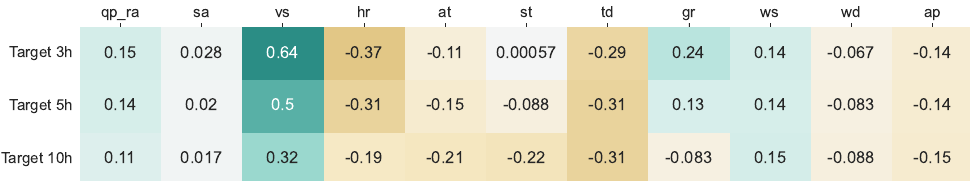
Figure 7. Class distribution of the visibility data, where 0 represents no extreme events and 1 denotes the extreme samples.